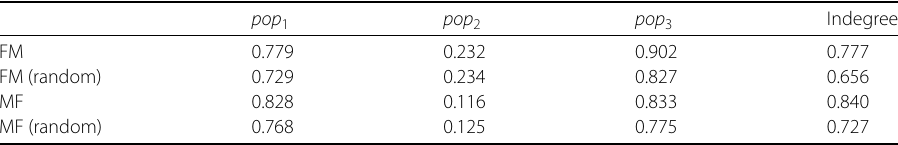
Table 7 The proportions of the receivers’ centrality indices that are larger than those of the senders’ when sending messages pop 1 pop 2 pop 3 Indegree FM 0.779 0.232 0.902 0.777 FM (random) 0.729 0.234